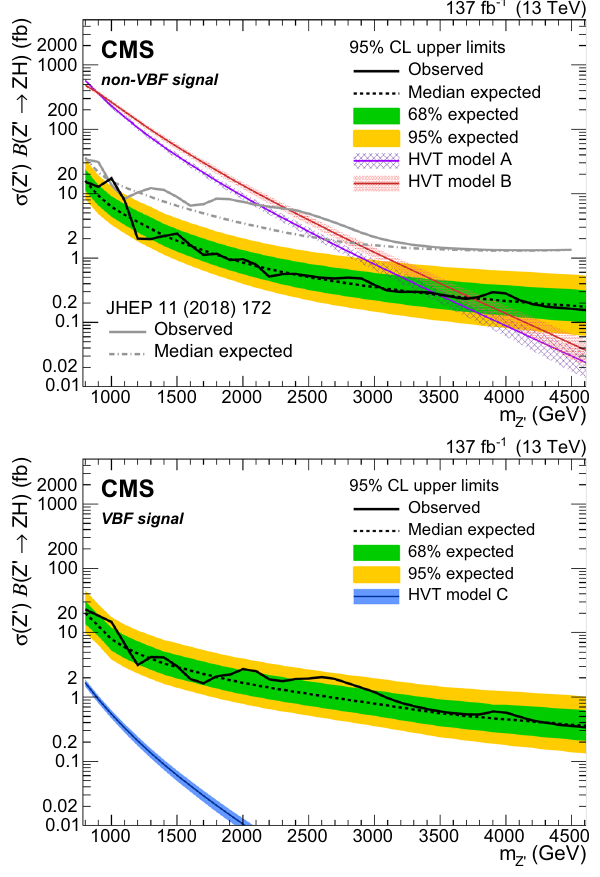
Fig. 7 Observed and expected 95% CL upper limit on σ B ( Z (cid:3) → ZH ) with all categories combined, for the non-VBF signal (upper) and VBF signal (lower), including all statisticaland systematicuncertainties. The innergreenbandandtheouteryellowband indicatetheregions contain- ing68and95%,respectively,ofthedistributionofexpectedlimitsunder thebackground-onlyhypothesis.Thesolidcurvesandtheirshadedareas correspond to the product of the cross section and the branching frac- tions predicted by the HVT models A and B (upper) and HVT model C (lower), and their relative uncertainties. The CMS search for a heavy resonance using 2016 data and the same final state [14] is shown as a comparison